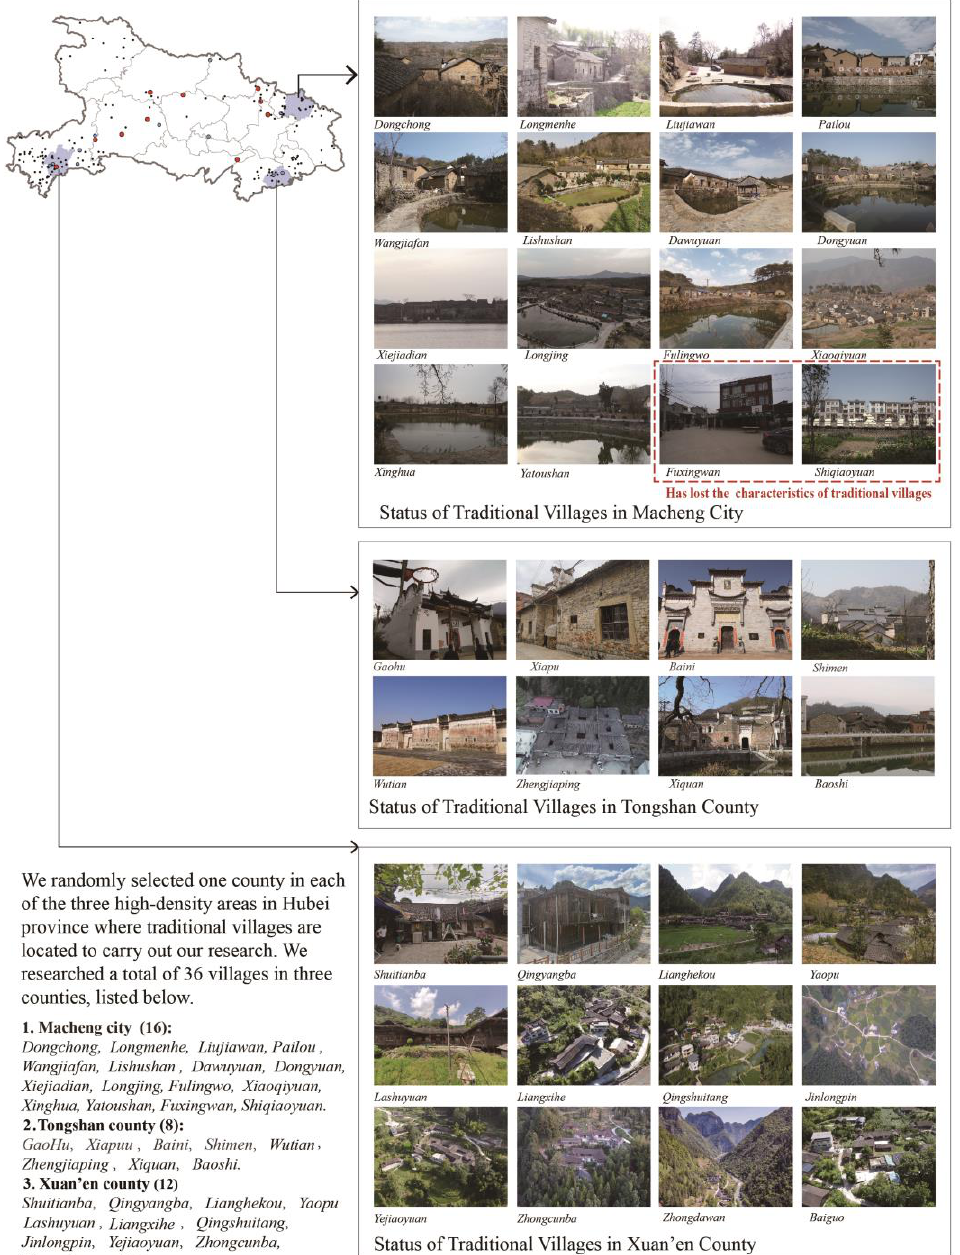
Figure 7. Results of the field research.